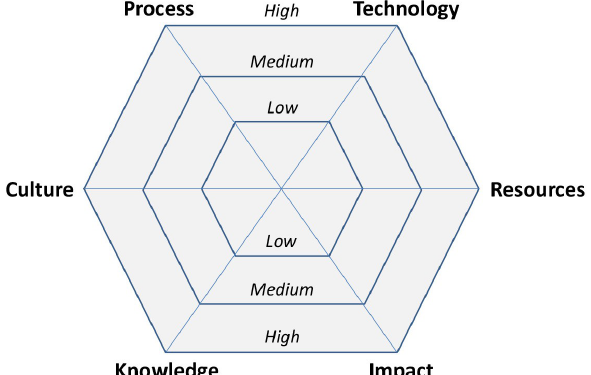
Figure 3. Assessment tool to support project health